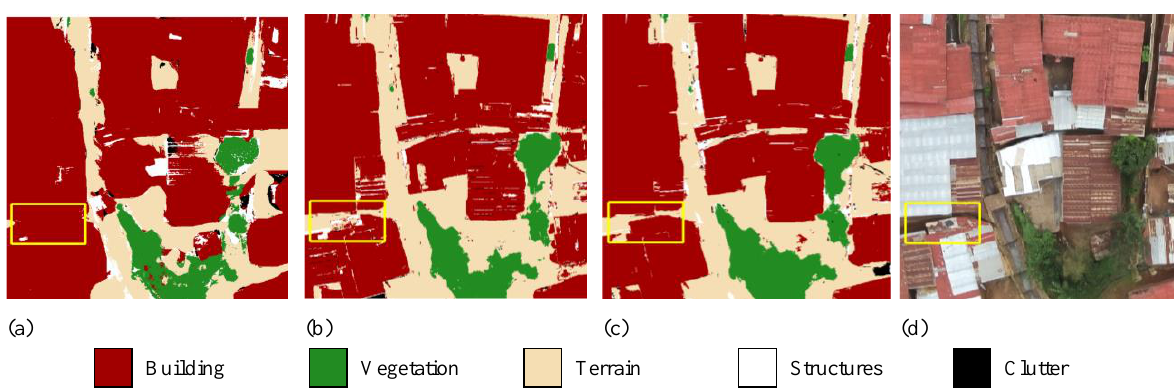
Figure 1. Sample classification results of the RD (a), R2ST (b) and R2ST_all (c) feature sets for the 5-class problem, with the RGB reference image (d). The yellow boxes indicate footpaths that are misclassified as buildings in RD due to DSM